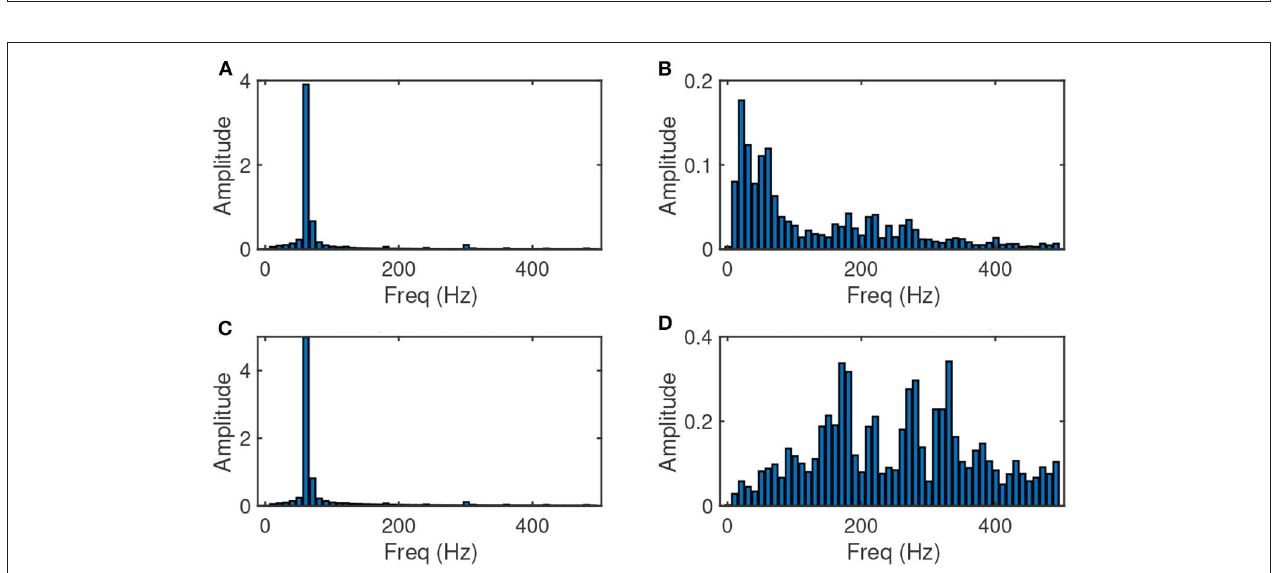
FIGURE 5 | Examples of complementary electrical load sensing events (normalized by the signal energy). (A) Stove, electrical features. (B) Stove, vibration features. (C) Kettle, electrical features. (D) Kettle, vibration features.